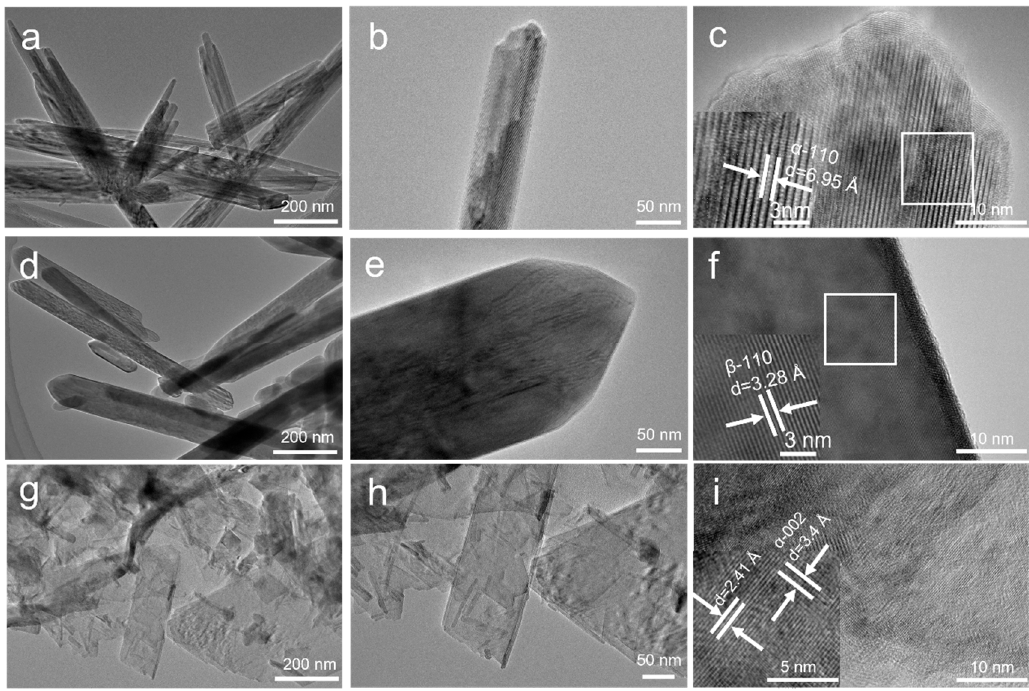
Figure 3. TEM images of ( a – c ) α -MnO 2 , ( d – f ) β -MnO 2 , and ( g – i ) δ -MnO 2